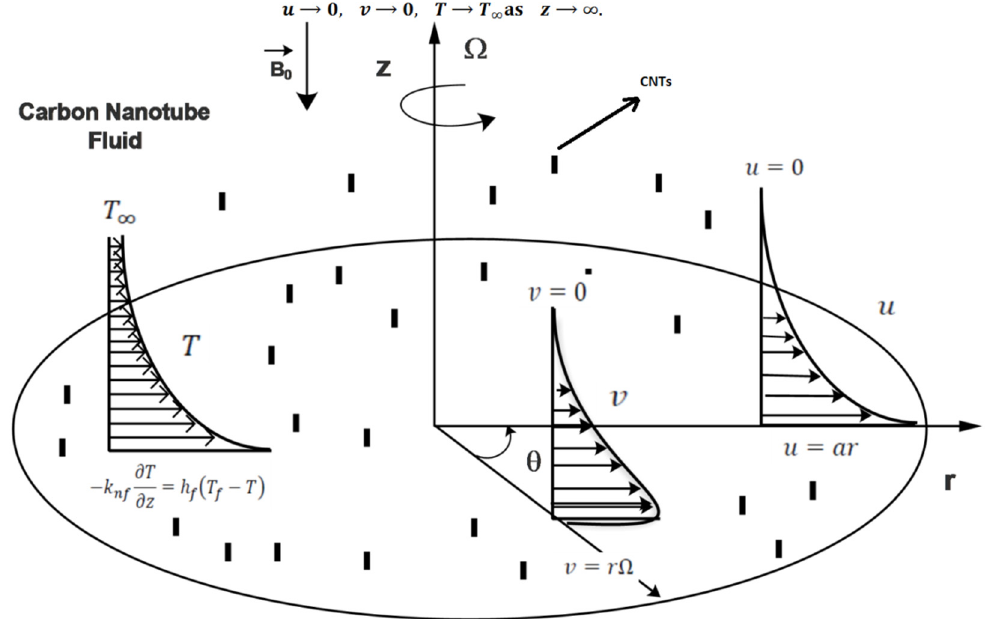
Figure 1. Geometry and coordinates of model.